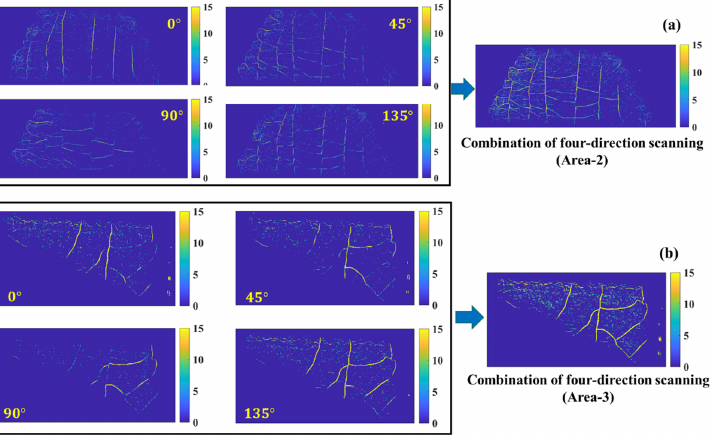
Figure 16. Detection results of two small areas: ( a ) results of individual scans along each direction and their superimposed results in Area-2; ( b ) results of individual scans along each direction and their superimposed results in Area ‐ 3.